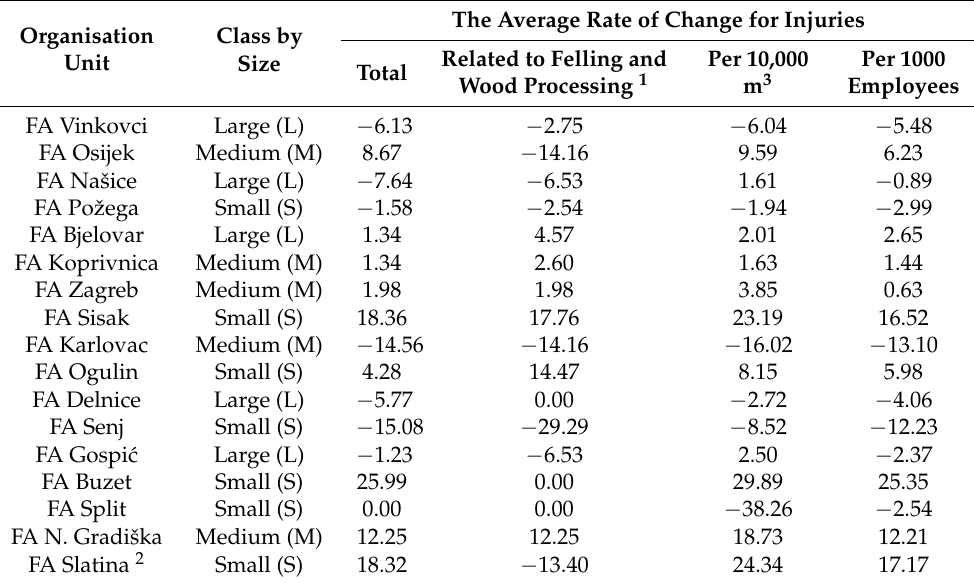
Table 4. The average rate of change for selected safety indicators by forest